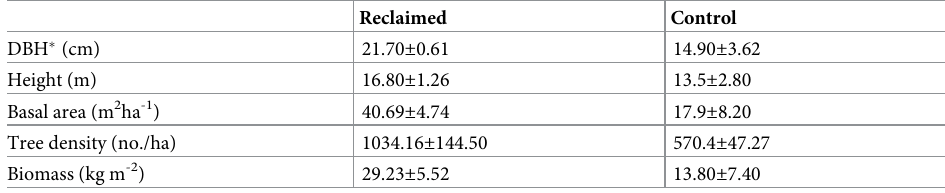
Table 6. Stand characteristics of the reclaimed and control (natural forest) sites